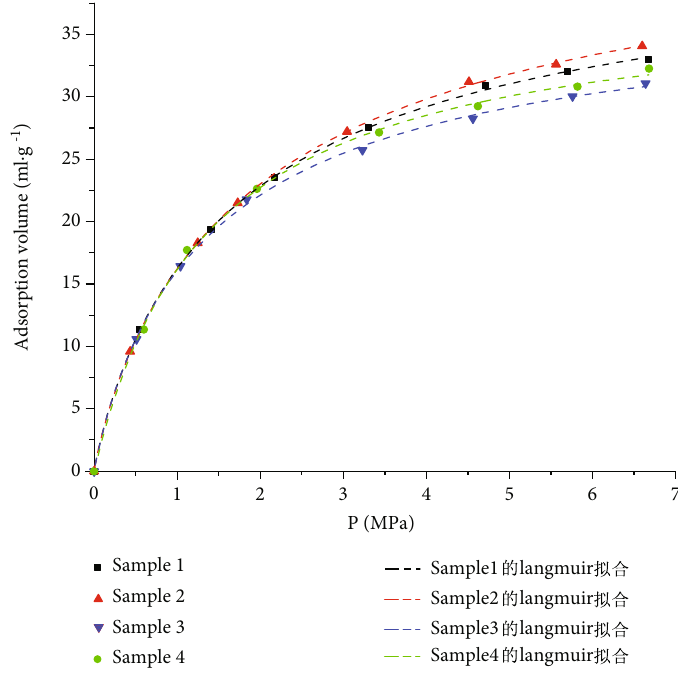
Figure 7: Gas adsorption experiment results and fi tting curve. Table 4: Gas adsorption experimental